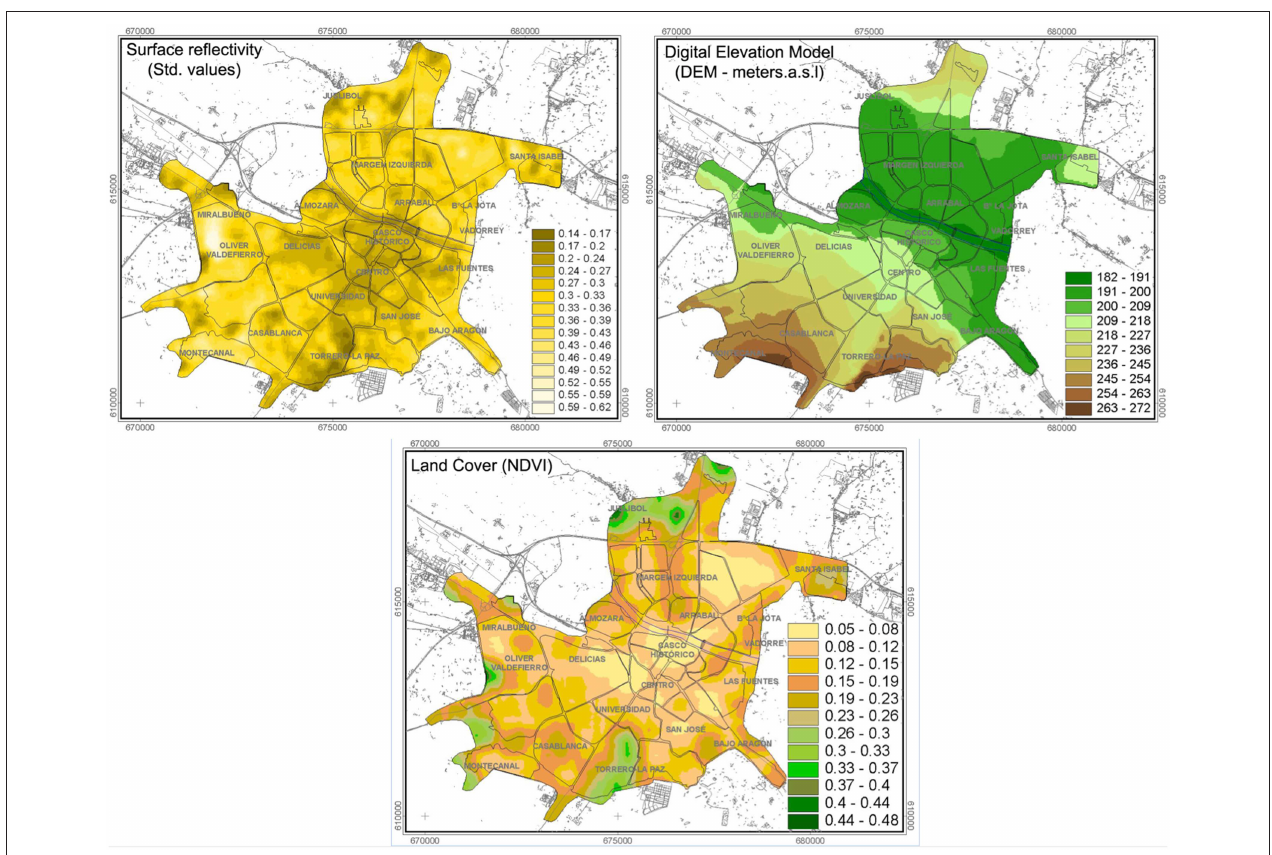
FIGURE 4 | Spatial distribution of surface reflectivity, elevation, and NDVI (low pass filter 21 × 21